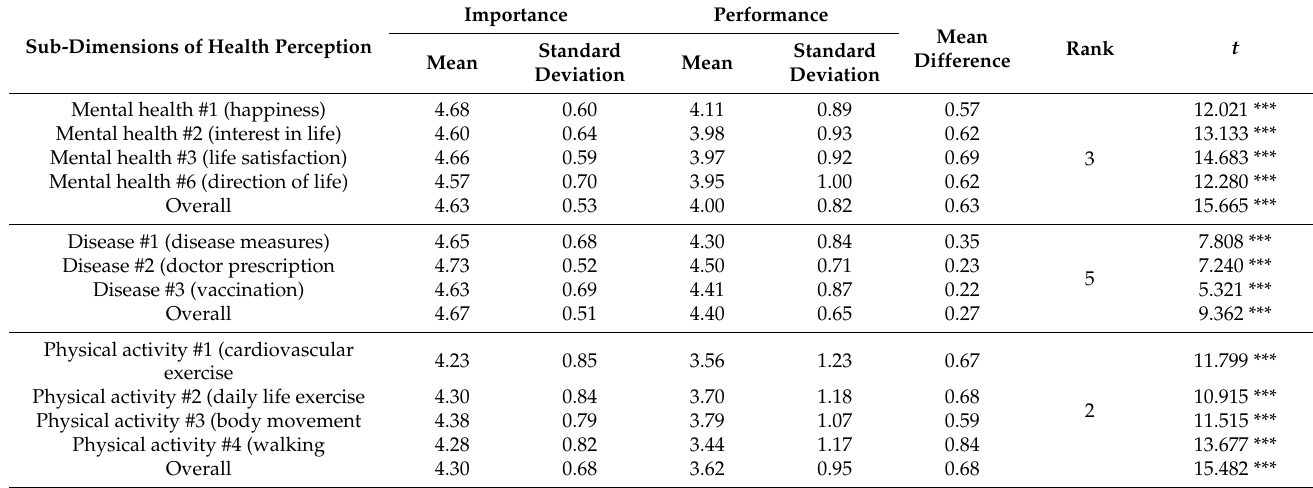
Table 6. Analysis of the difference between importance and performance by